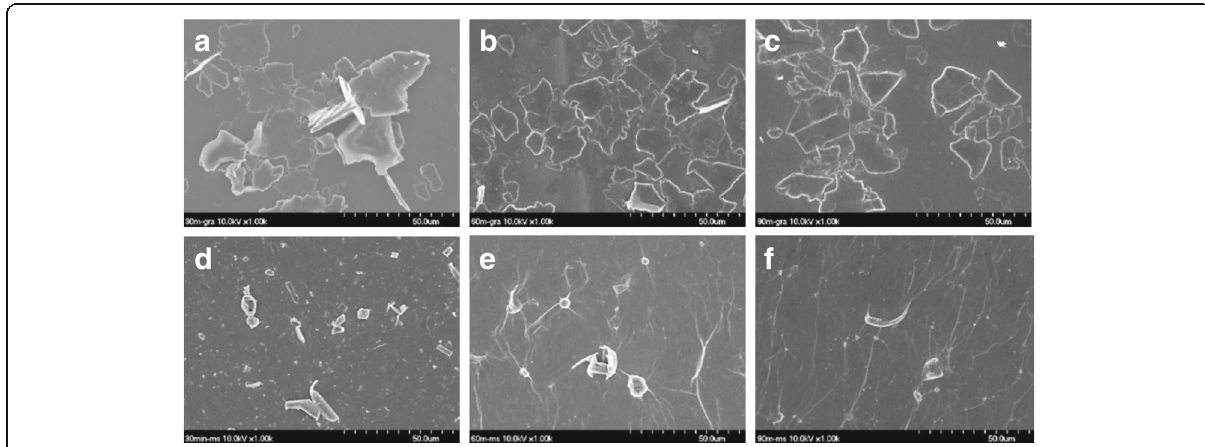
Fig. 2 SEM micrographs of mildly oxidized graphite and MS-exfoliated MOG, a MOG-30, b MOG-60, c MOG-90, d MOG-30-MS, e MOG-60-MS, and f MOG-90-MS